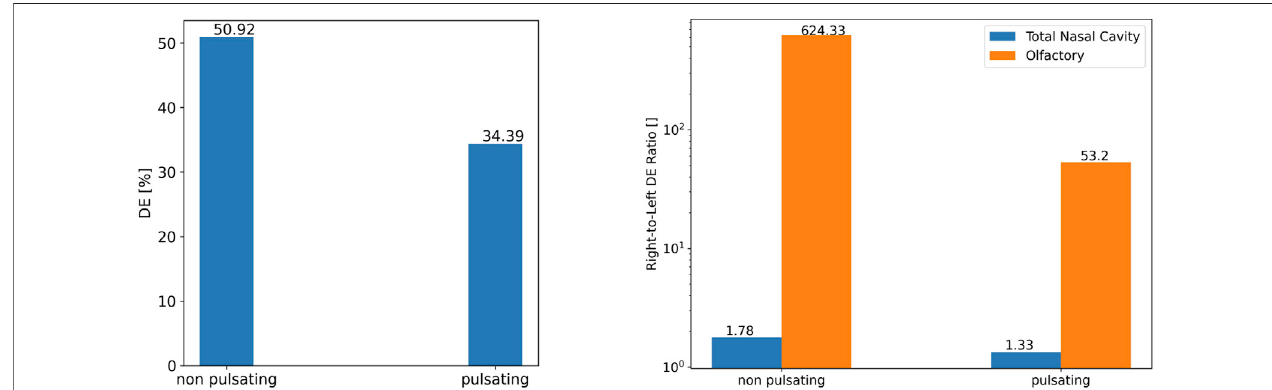
FIGURE 10 | The role of pulsation on 1 µm particle deposition ef fi ciency in the entire nasal cavity (left) and the right and left olfactory region (right: note: log scale).